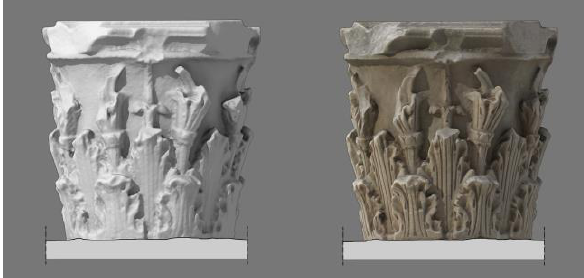
Figure 13. Once de-shadowed the apparent colour texture gets more close to a conventional diffuse colour texture, enabling more flexibility and reliability of objects under different illumination. Capitals formerly belonged to the Serapeum of Hadrian’s Villa then moved to the Poecile.